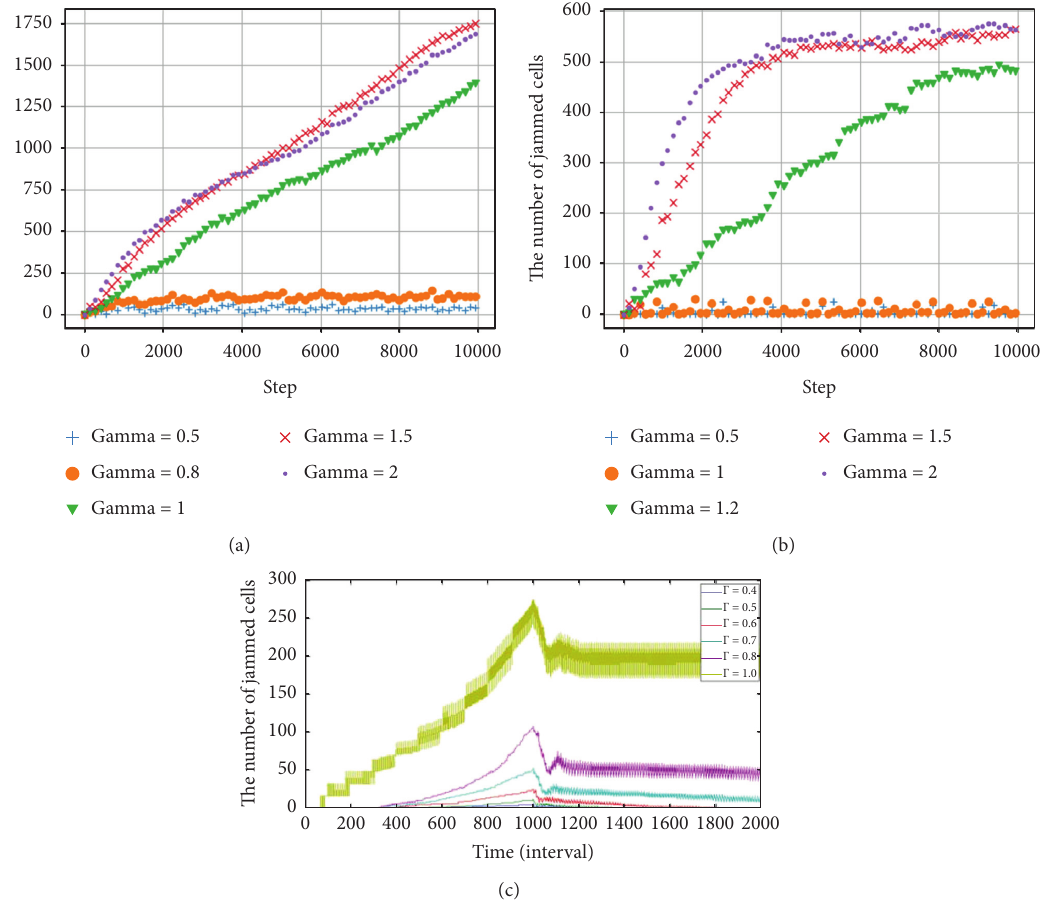
Figure 9: The number of jammed cells of an 8 × 8 network with one strategy and fixed phasing time for Γ � [0.5, 1, 1.2, 1.5, 2]. The method is successful to handle the traffic, if the number of jammed cells is low. (a) Fixed time traffic light. (b) The proposed traffic light phasing without ETL. (c) The proposed traffic light phasing by Qi et al.